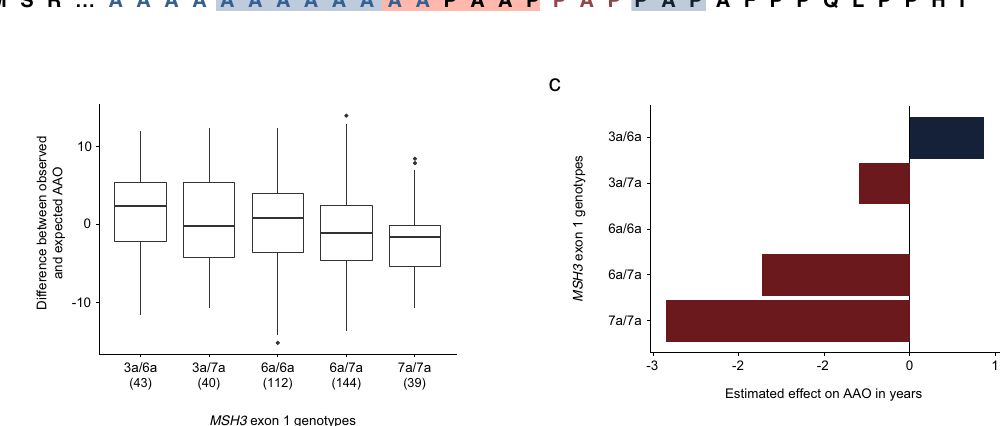
Fig. 3 The length polymorphism in exon 1 of MSH3 and its correlation within different genotypes with age at onset (AAO) in X-linked dystonia- parkinsonism (XDP) patients. a cDNA and amino-acid sequences showing the wild-type sequence, the shortest (c.162_179del;199_207del), and the longest (c.181_189dup) allele of MSH3 exon 1, i.e., 6a, 3a, and 7a alleles, respectively. The sequences are based on the MSH3 transcript ID ENST00000265081.7 (https://www.ensembl.org). Blue shading highlights the region deleted in the shortest allele (stretch of six alanines (A) and